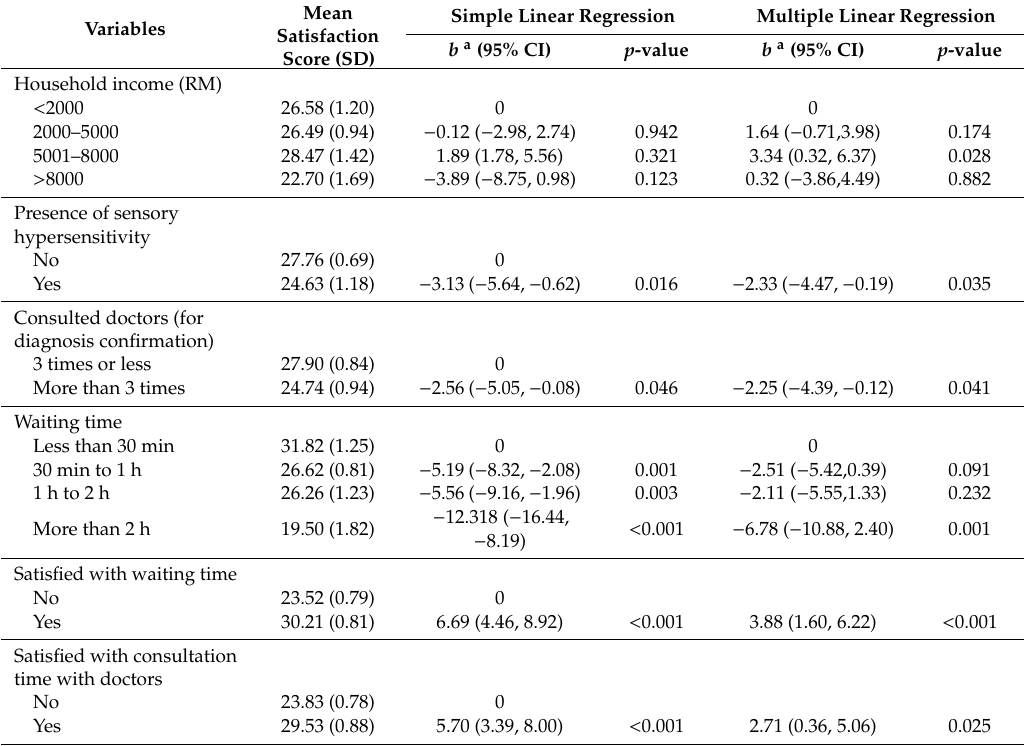
Table 4. Predictors of caregivers’ satisfaction with the health care management of children with ASD at primary care in Kelantan ( n = 126).